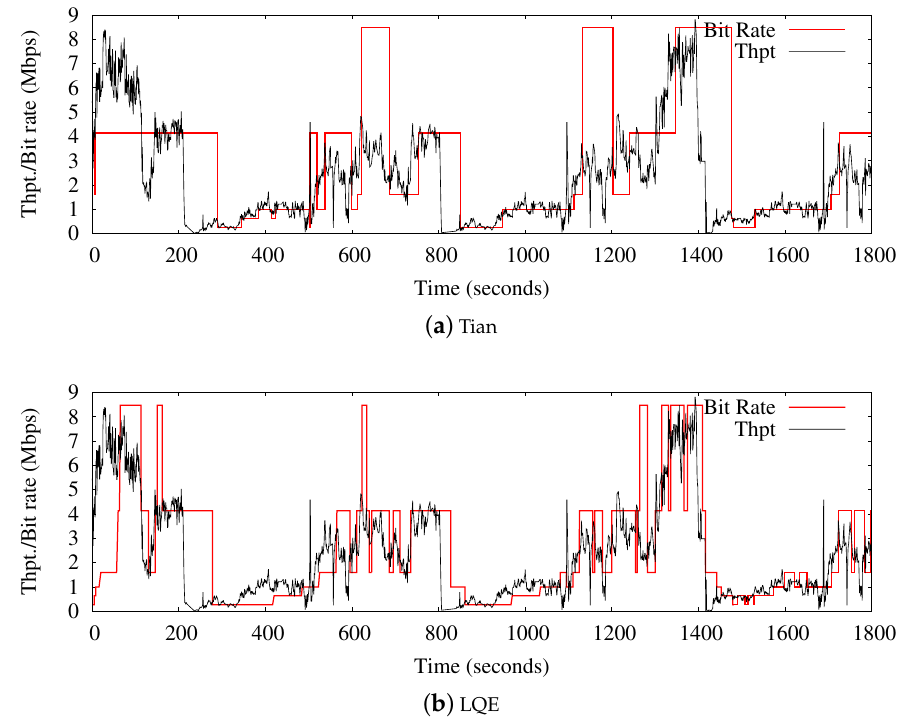
Figure 7. Examples of Bit Rate Changes according to